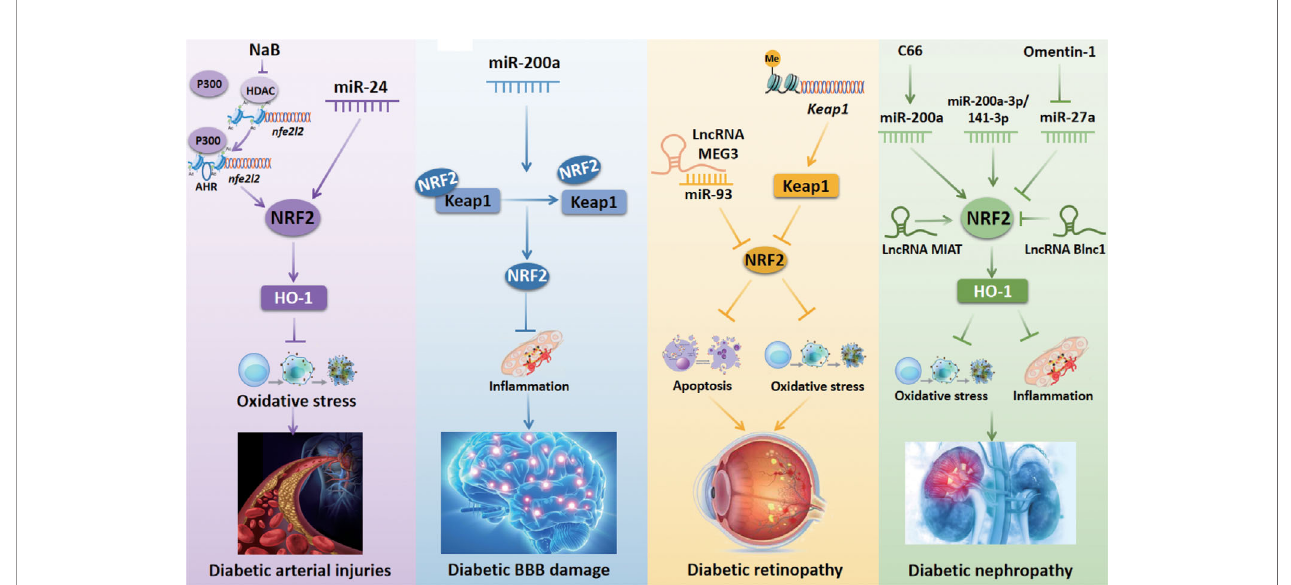
FIGURE 3 | NRF2-related epigenetic mechanisms in diabetic vascular complications. Inhibition of HDAC activity by NaB increases the occupancy of AHR and P300 at nfe2l2 promoter to promote the transcriptional activation of nfe2l2 , thus protecting against diabetic arterial injuries. miR-24 stimulates the NRF2/HO-1 signaling pathway to prevent oxidative stress induced by diabetic arterial injuries. miR-200a regulates the Keap1/NRF2 axis to prevent in fl ammation, thus improving diabetic BBB damage. The lncRNA MEG3 inhibits DR-induced apoptosis via downregulating the miR-93/NRF2 pathway. Histone methylation of the Keap1 promoter region increases Keap1 expression and subsequently inhibits the activity of NRF2 to aggravate oxidative stress in DR. C66 upregulates NRF2 expression to protect against DN-induced oxidative stress by increasing miR-200a expression. The upregulation of miR-200a-3p/141-3p modulates the NRF2 to protect against DN. Omentin-1 downregulates miR-27a and subsequently increases NRF2 expression to inhibit oxidative stress and in fl ammation in DN. The lncRNA MIAT improves DN by stimulating NRF2. The lncRNA Blnc1 reduces NRF2 expression to cause oxidative stress and in fl ammation in DN. NaB, sodium butyrate; HDAC, histone deacetylase; AHR, aryl hydrocarbon receptor; NRF2, nuclear factor erythroid 2-related factor 2; miR, microRNA; lncRNA MIAT, long non-coding RNA myocardial infarction-associated transcript; HO-1, heme oxygenase-1; Keap1, Kelch-like ECH-associated protein 1; BBB, blood-brain